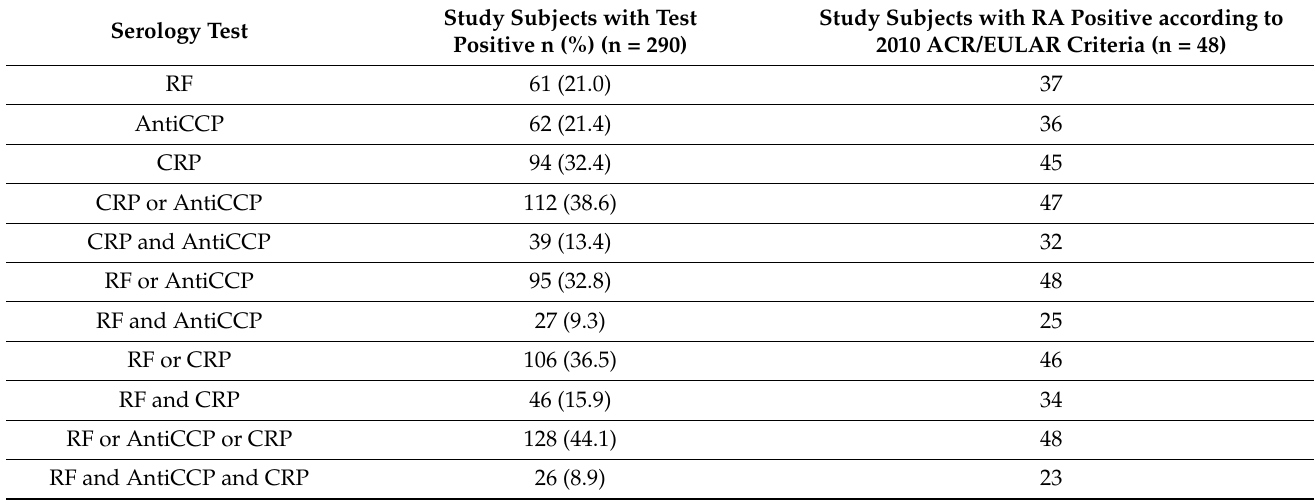
Table 4. Distribution of study subjects by serology test results.